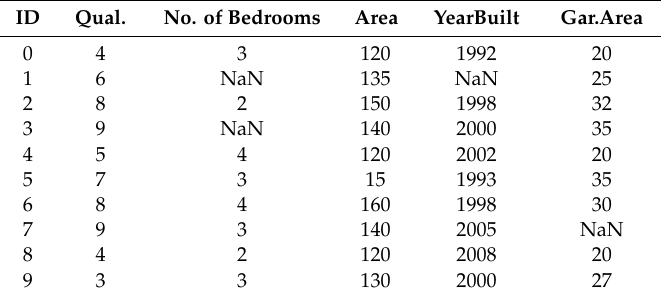
Table 7. Example of missing data in the